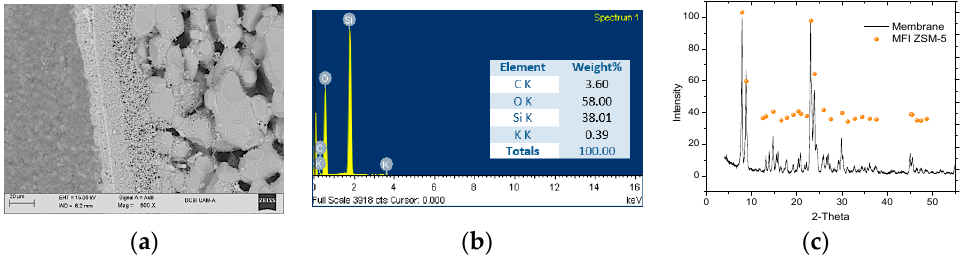
Figure 1. ( a ) cross section of the mesoporous support, formed by three layers and a zeolite film, ( b ) EDS membrane analysis, ( c ) MFI membrane XRD diffraction